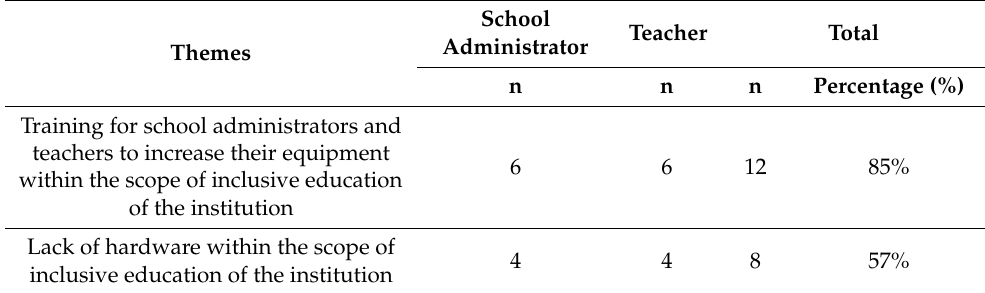
Table 3. Providing training to increase the equipment of school administrators and teachers within the scope of inclusive education of the